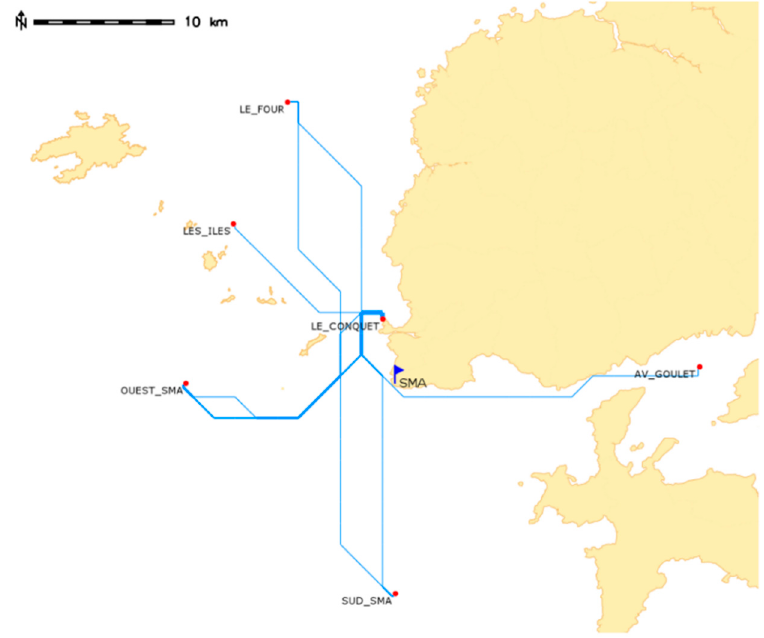
Figure 12. Screenshot of a sample result in output from t.vect.createRoutes.py for the “moment” mode.